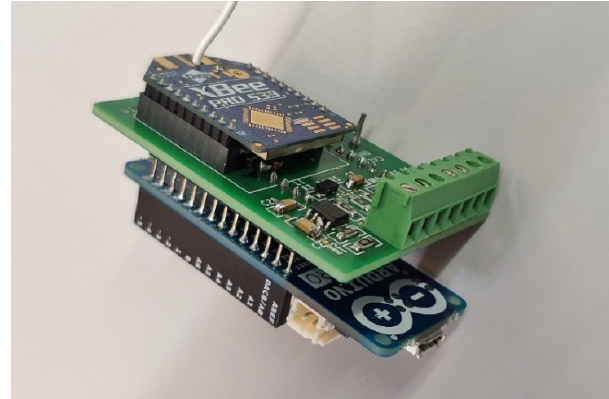
Figure 8. Detail of the Smart Measuring Node prototype